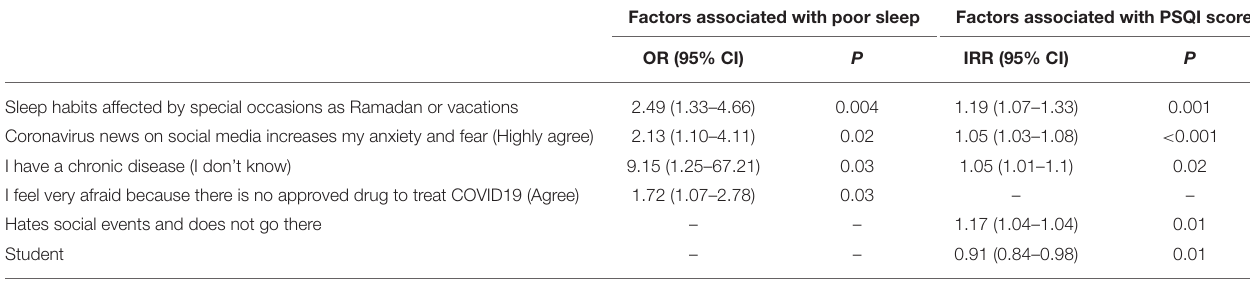
TABLE 3 | Factors associated with poor sleep and PSQI score.